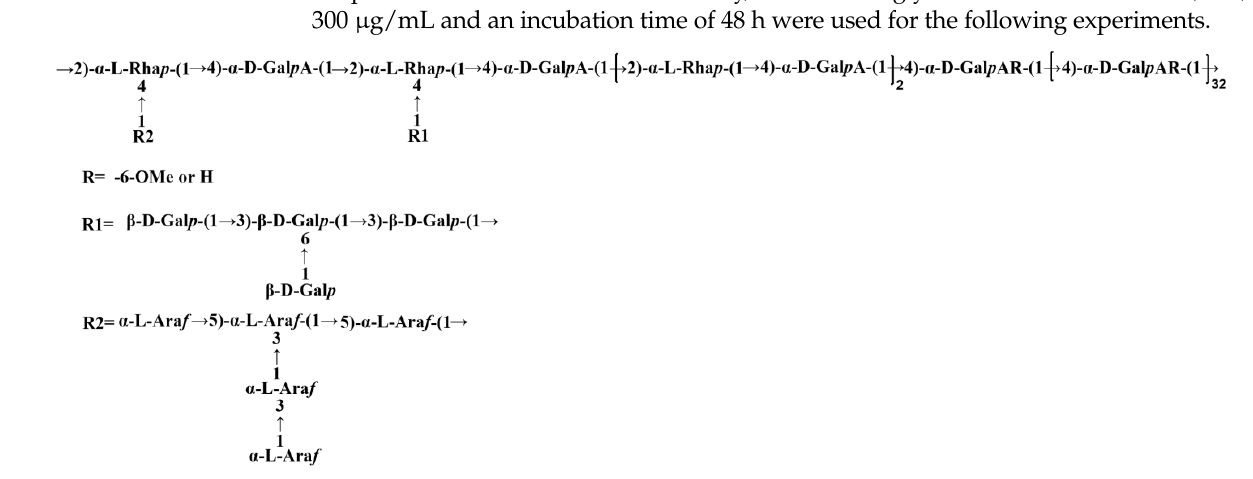
Figure 8. Possible repeat unit structure of GP2a. Table 4. Cell viability of RAW 264.7